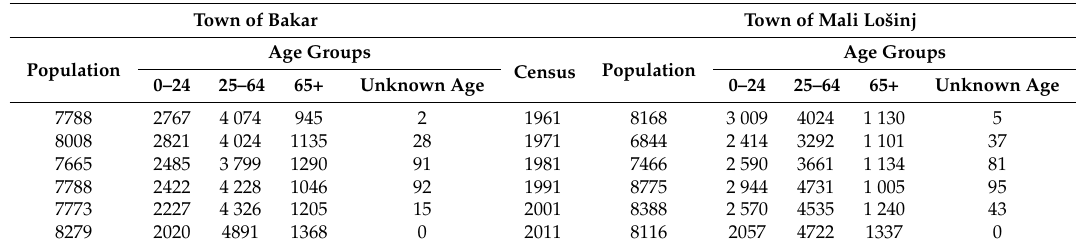
Table 1. Population census and three age sub-groups according to census years 1961–2011 in the areas of the towns of Bakar and Mali Lošinj